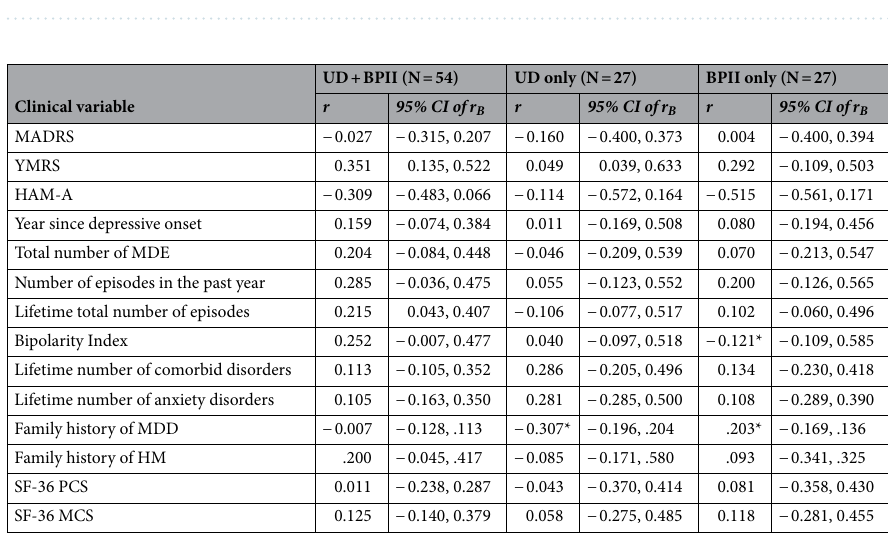
Table 2. Correlations between clinical variables and AD at the right SLF (temporal). MADRS Montgomery– Åsberg Depression Rating Scale, YMRS Young Mania Rating Scale, HAM-A Hamilton Anxiety Rating Scale, correlation coefficient. *Statistically significant, where the observed statistics was not within the 95% CIs of the bootstrapped statistics.